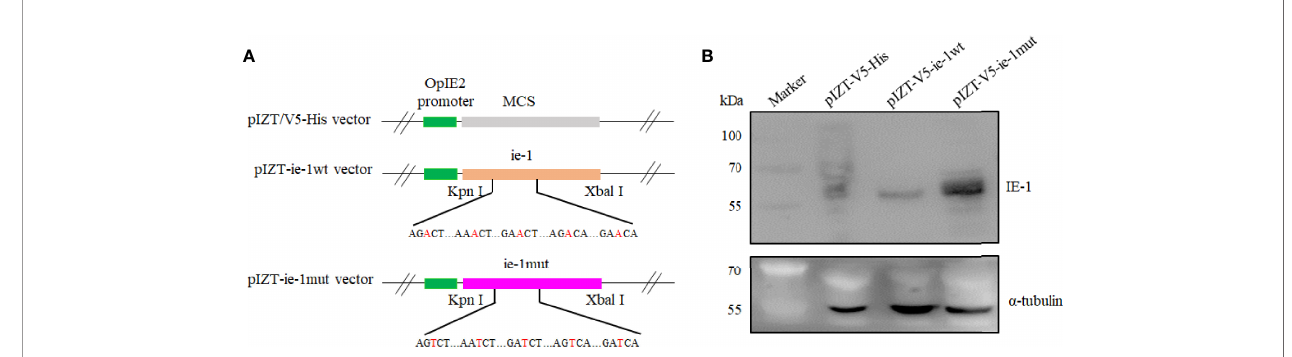
FIGURE 3 | Construction of the ie-1wt and ie-1mut plasmids and detection of the expression level of IE-1 in BmN cells transfected with plasmids. (A) The wild-type and mutant ie-1 plasmids were constructed by cloning a 1,752-nt length fragment (remove the TAA) encompassing the m6A peak region in the ie-1 mRNA and a mutant fragment with A > T mutations at the potential m6A sites, respectively. (B) IE-1 expression was detected from the plasmid-transfected BmN cells with Western blotting assay. pIZT-V5-His plasmid as the